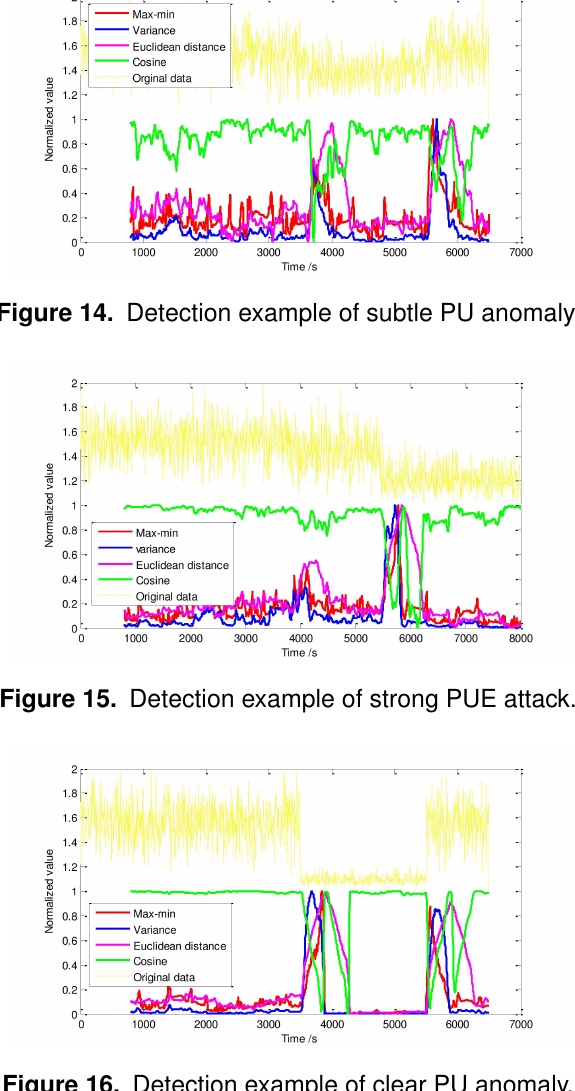
Figure 16. Detection example of clear PU